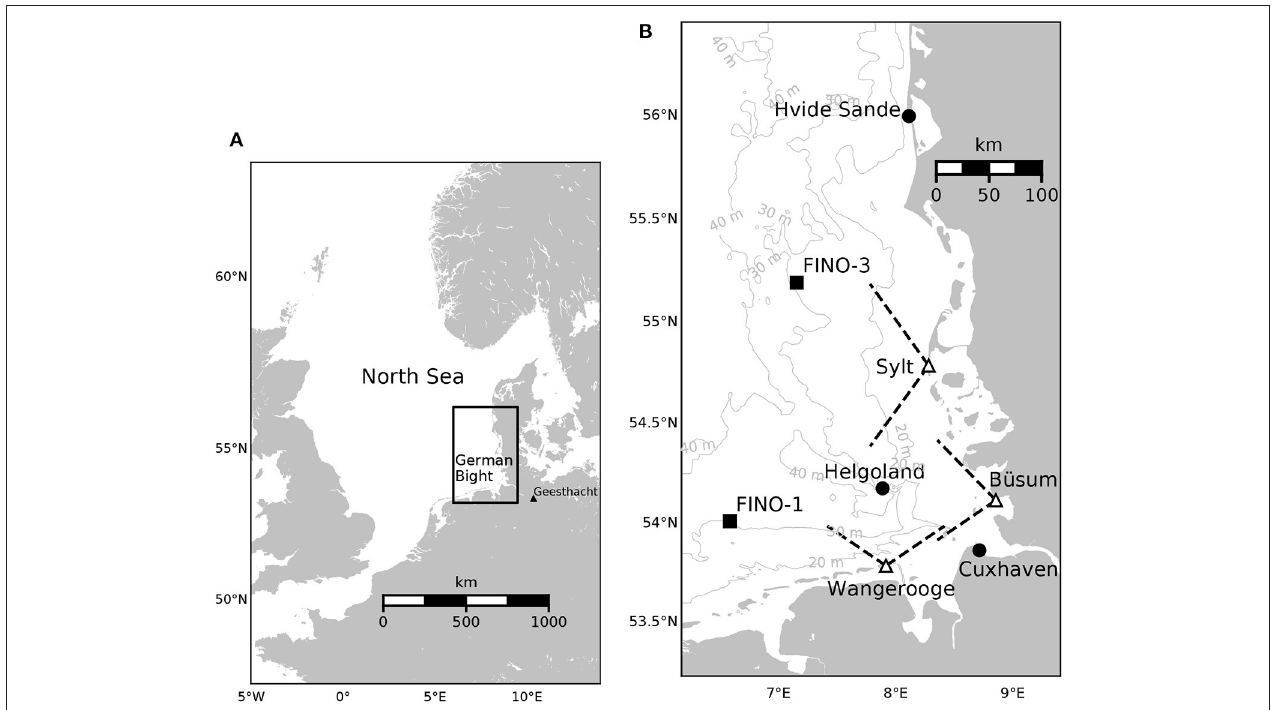
FIGURE 1 | (A) Map of the North Sea with the German Bight and the model domain indicated by a black rectangle. (B) Detailed map of the area considered in this study with information on the used observation systems. Black dots indicate tide gauges, triangles mark positions of HF radar stations and black squares refer to fixed platforms with ADCP measurements. The dashed black line indicate the approximate look directions of the radar systems and the grey lines in the background refer to the 20, 30, and 40 m